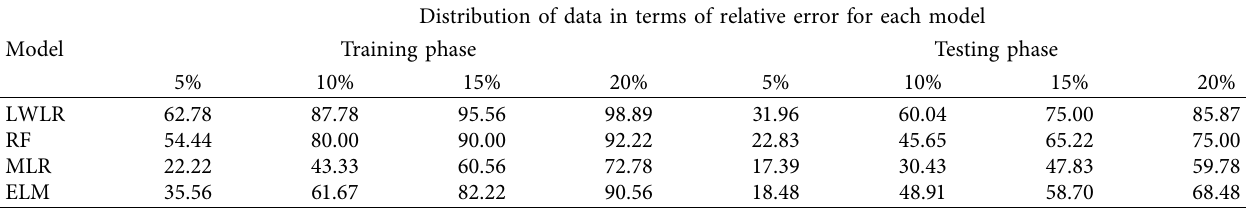
Table 6: A comparison of the performance outcomes for the uncertainty ( U